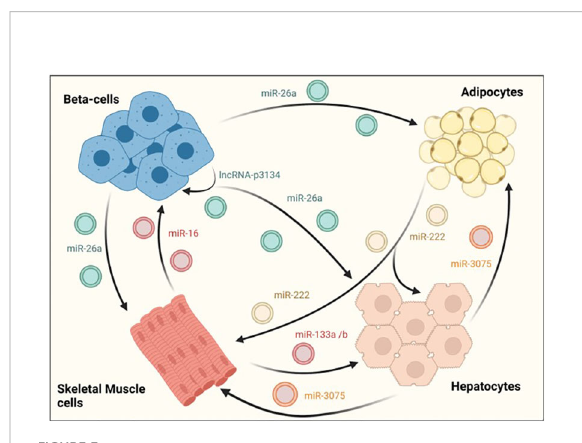
FIGURE 3 EV-mediated crosstalk between tissues regulating glucose homeostasis. b -cells secrete exosomes containing several RNA species, such as miR-26a that enhances insulin sensitivity in hepatocytes, white adipose tissue and skeletal muscle. On their part, exosomes derived from skeletal muscle cells also affect b – cell function and mass, demonstrating the existence of a two- way communication between pancreatic islets and insulin sensitive tissues. An intrincate crosstalk between hepatocytes, skeletal muscle and adipose tissue has also been demonstrated. For example, hepatocyte-derived exosomes containing miR- 3075 affect the capacity of adipocytes and skeletal muscle cells to uptake glucose. Similarly, exosomes released from skeletal muscle cells may enhance hepatic insulin sensitivity through miR-133a/b. In contrast, miR-222 found in adipocyte-derived exosomes, impairs insulin action in other insulin target